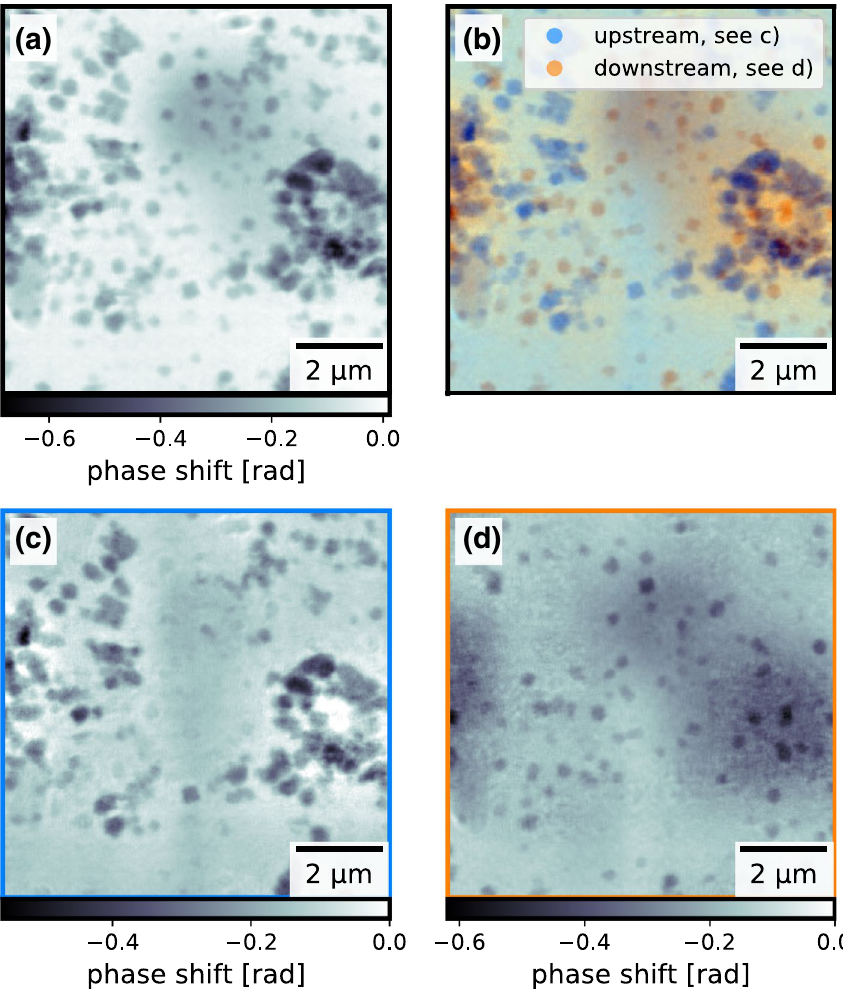
Figure 3. Phases of the reconstructed objects from the single polyimide foil experiment in direct comparison: ( a ) single object slice reconstruction using ePIE ( b ) colored overlay of the upstream object slice (blue, c ) and the downstream object slice (orange, d ), reconstructed using 3PIE. The figure was created using matplotlib 35 (version 3.1.3 36